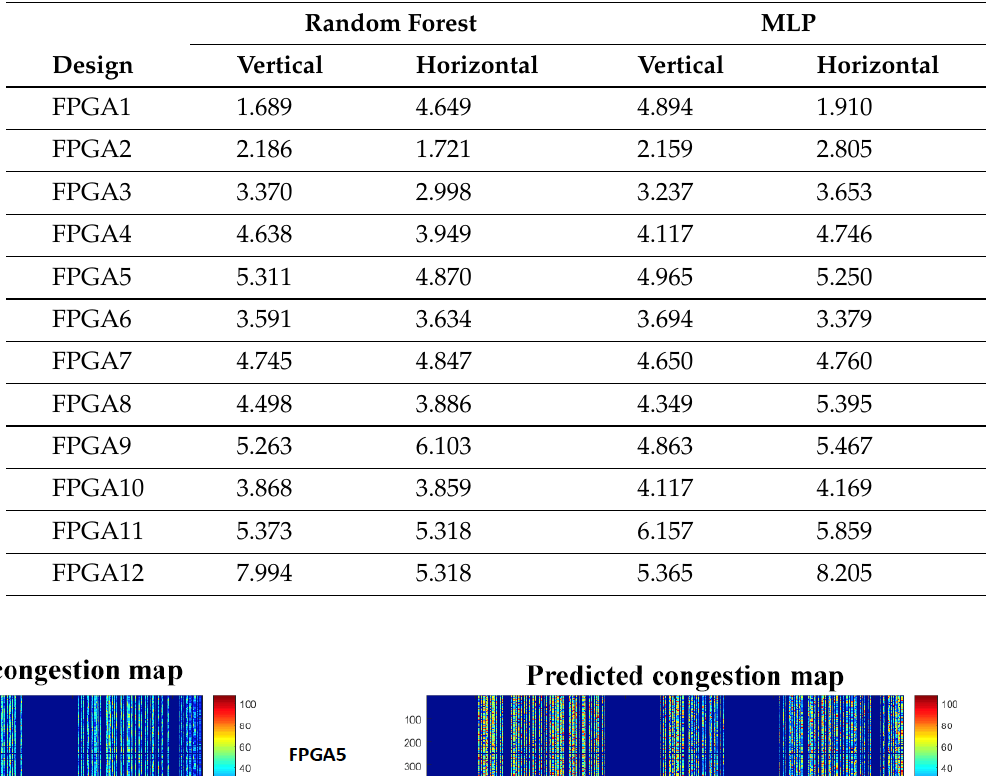
Table 5. MAPE values for predicted congestion values for Random Forest and Multi-Layer Percep- tron models.